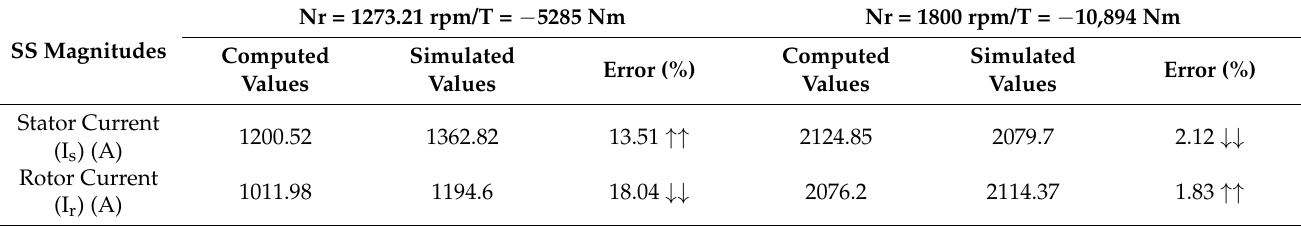
Table 1. Comparison of SS